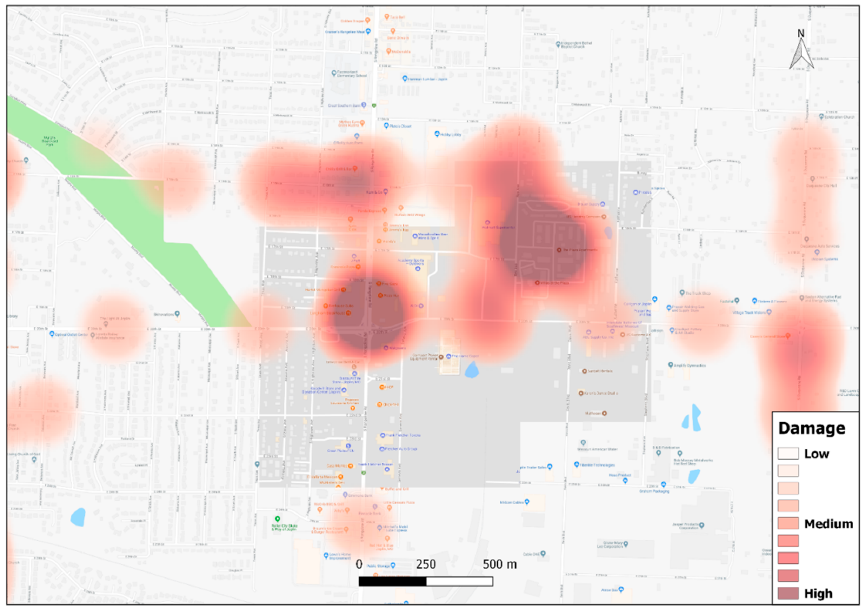
Figure 11. Heat map for ‘damage’ category containing spatial references.